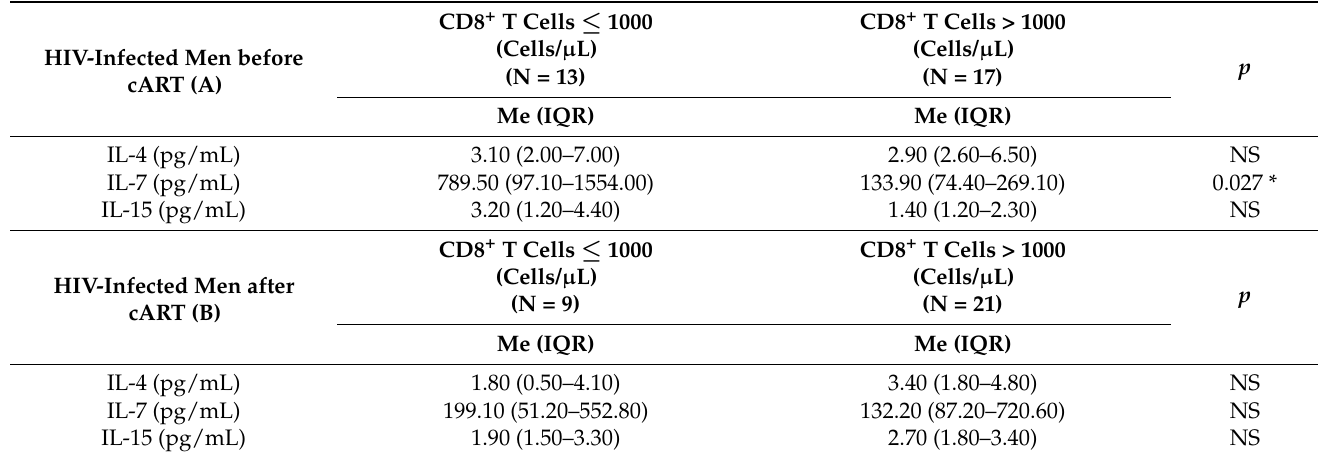
Table 5. Results of IL-4, -7 and -15 before (group A) and after (group B) cART in HIV-infected men by CD8+ T-cell count (below and above 1000 cells/ µ L) with statistical